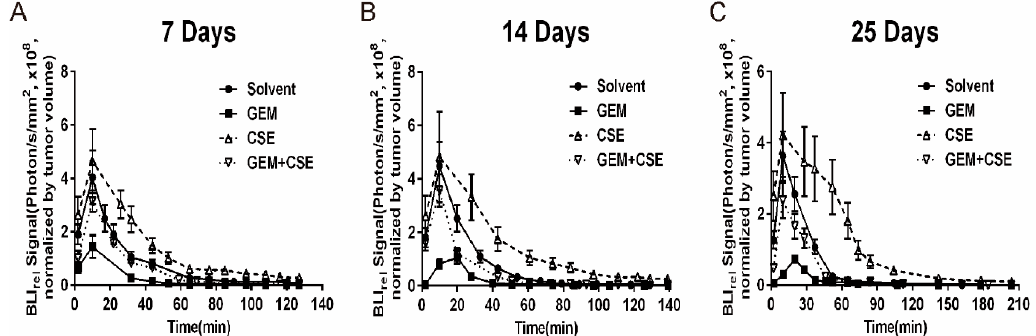
Figure 4. Relative bioluminescence imaging (BLI rel ) signal-time curves of D-lucferin in xenograft nude mice implanted with BxPC3 luc cells. Xenograft nude mice were treated with gemcitabine (GEM, 50 mg / Kg, 3 / wk, i.v.), coix seed extract (CSE, 12.5 mL / Kg, q.d., i.v.) or the combination of gemcitabine and coix seed extract (GEM, 50 mg / Kg, 3 / wk, i.v.; CSE, 12.5 mL / Kg, q.d., i.v.). At days ( A ) 7, ( B ) 14 and